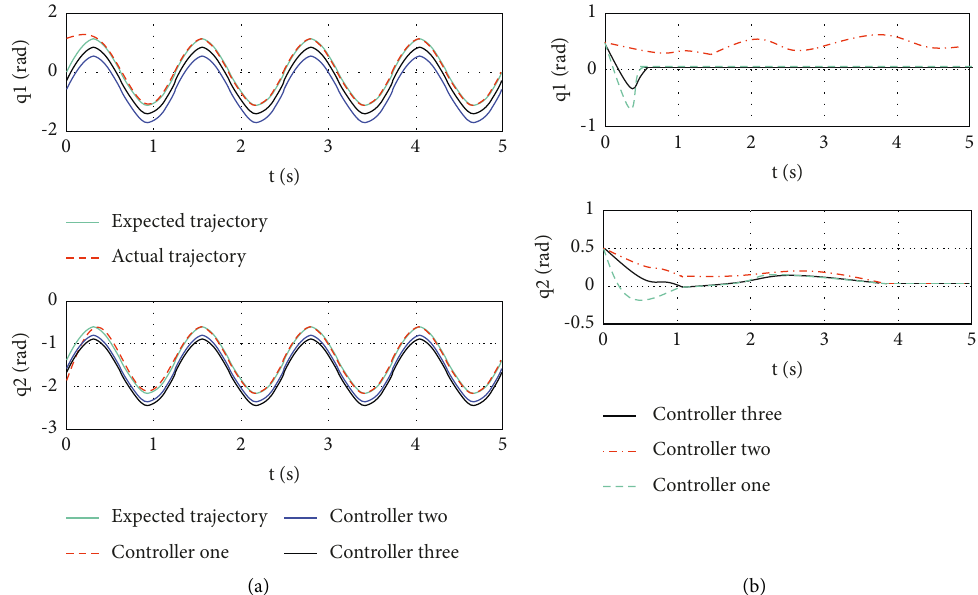
Figure 4: Position comparison curve. (a) Comparison curves of position trajectories under three different controllers. (b) Comparison curve of position error under three different